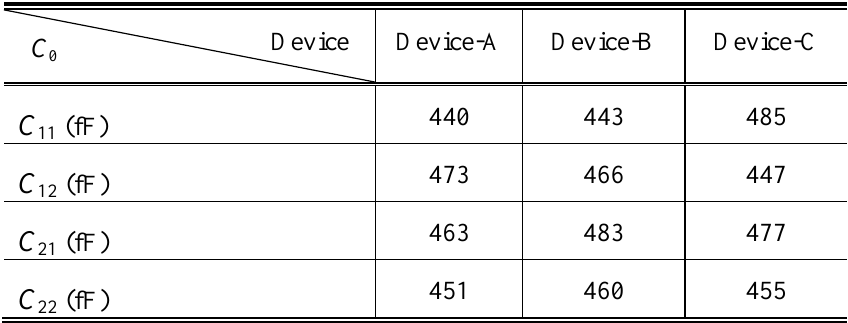
Table 2. The initial capacitances ( C Device-B and